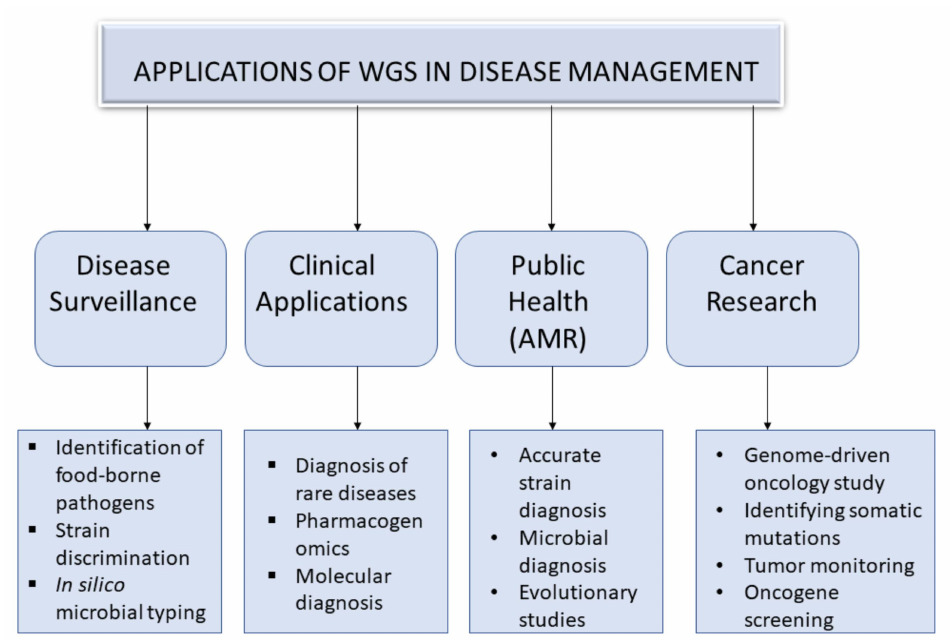
Figure 2. A diagram representing overview of general WGS applications. AMR: Antimicrobial Resistance